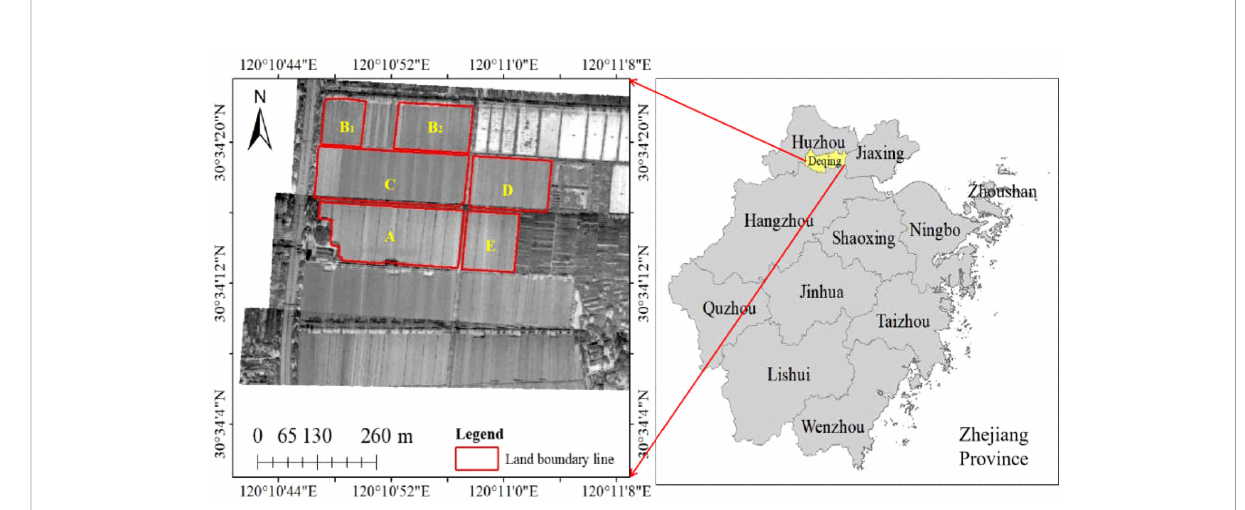
FIGURE 1 Geographical map of the study area. The left image shows the MiniSAR radar images and the locations of (A – E) parcels in the study area. The maps on the right show the geographical location of the study